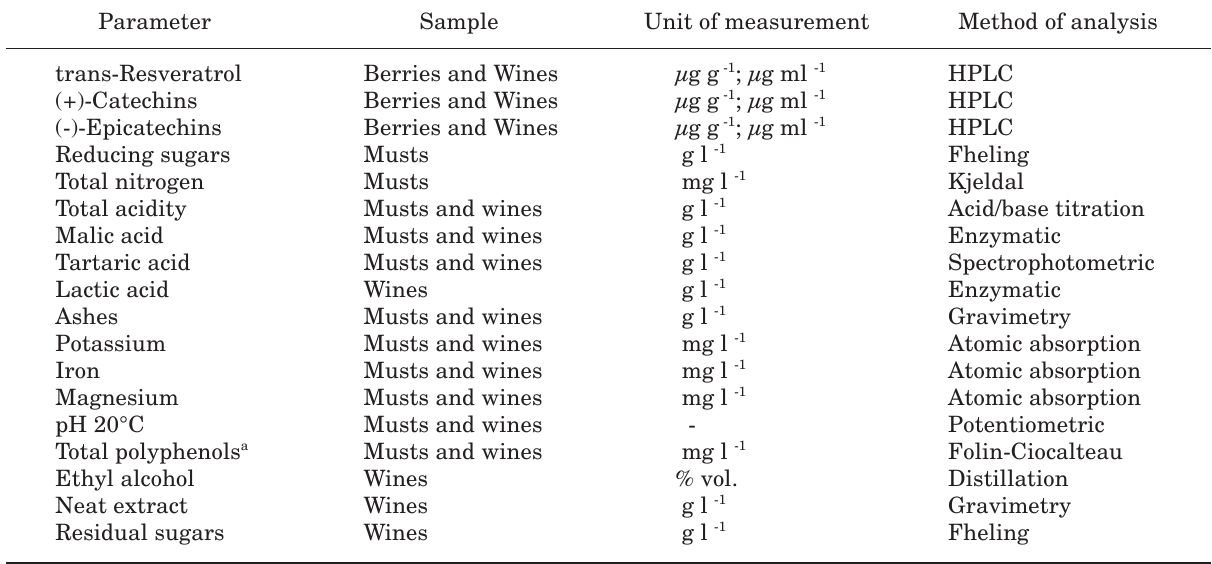
Table 1. Chemical analysis carried out on cv. Trebbiano d’Abruzzo berries, musts and wines during the